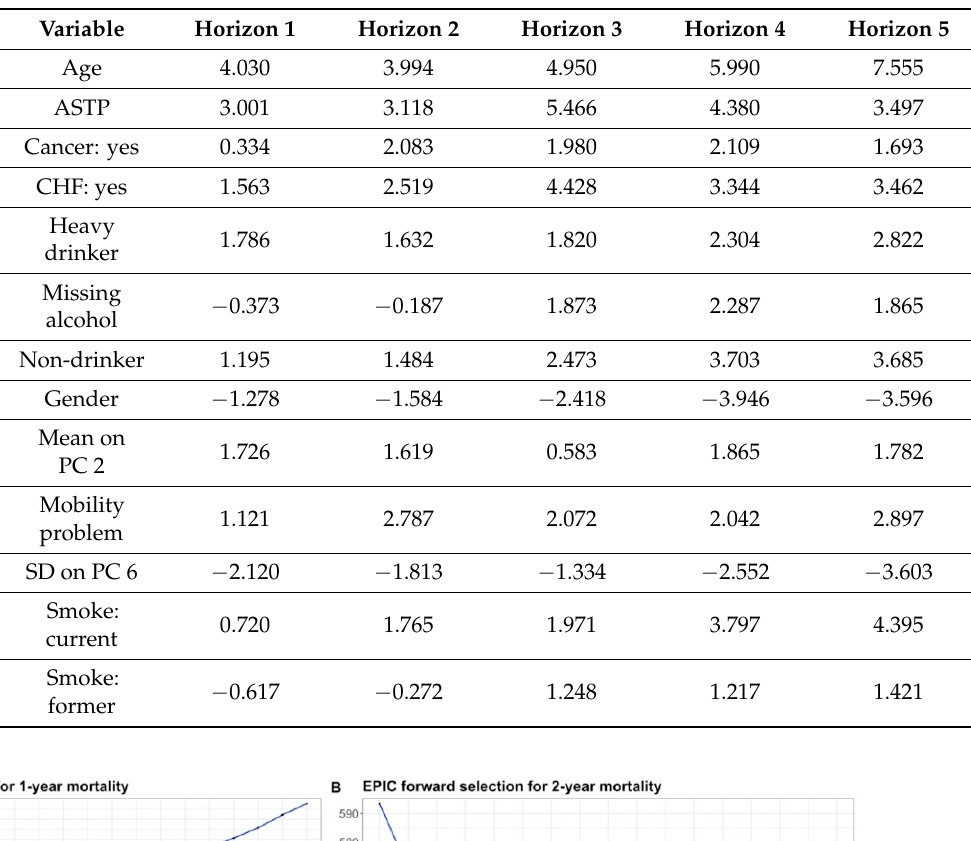
Table A3. t-statistic values of the variables selected in the combined model across years.